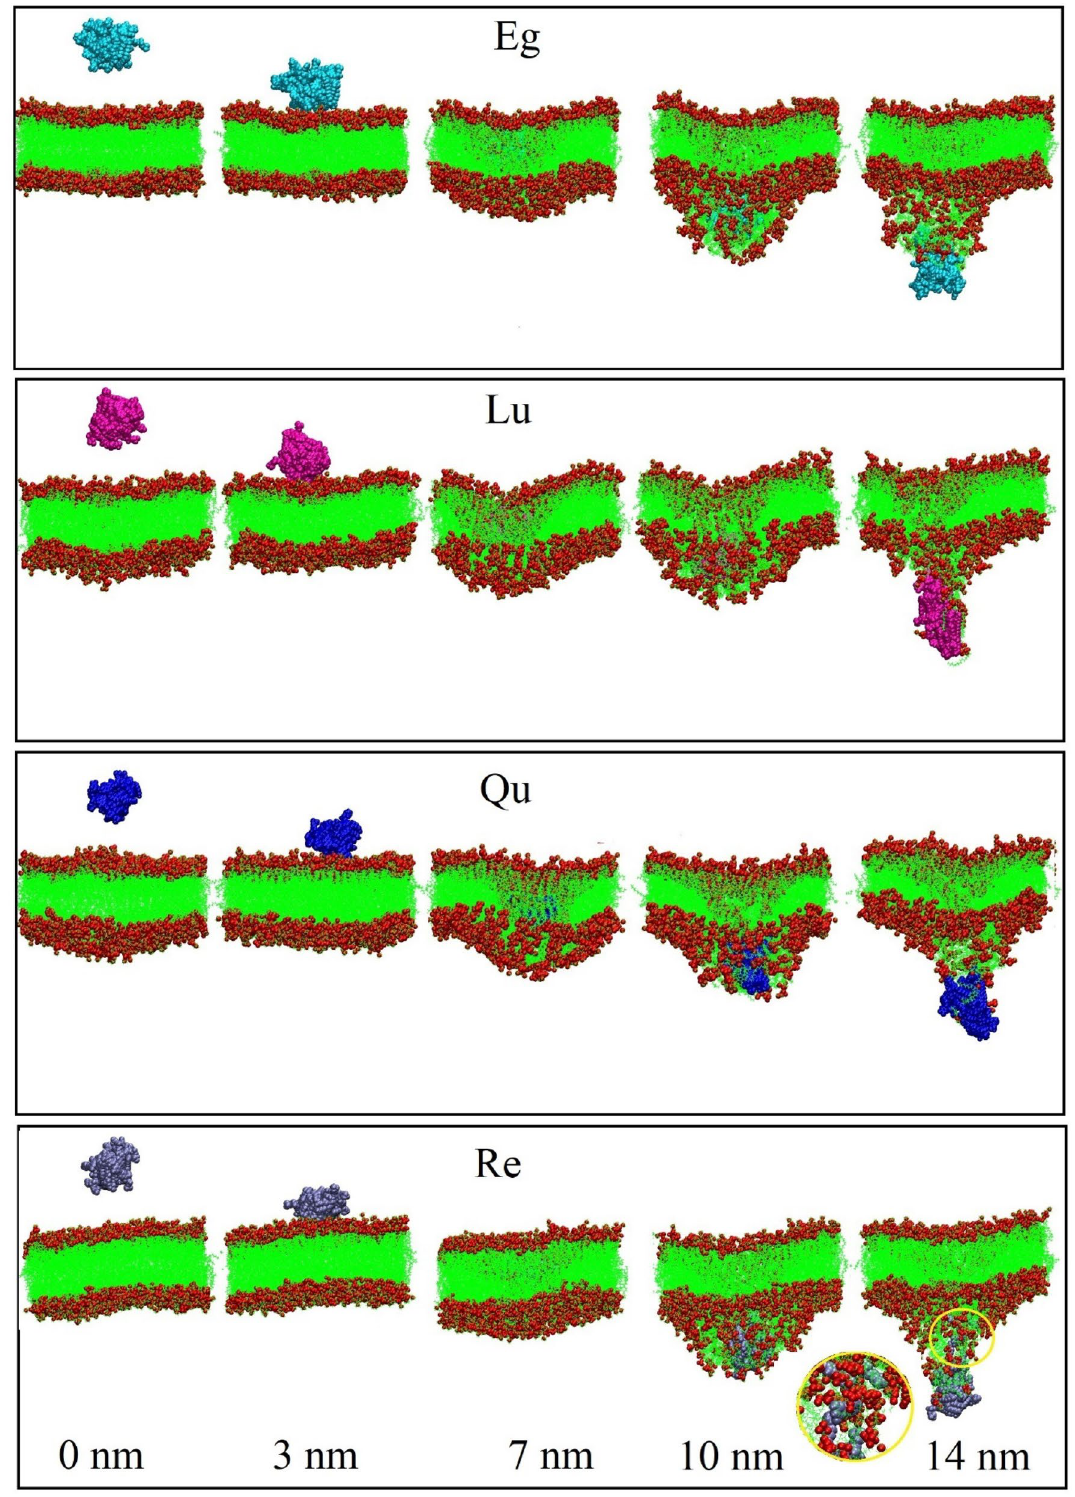
Figure 19. Side-view snapshots of the phytosome and membrane at different position during the SMD